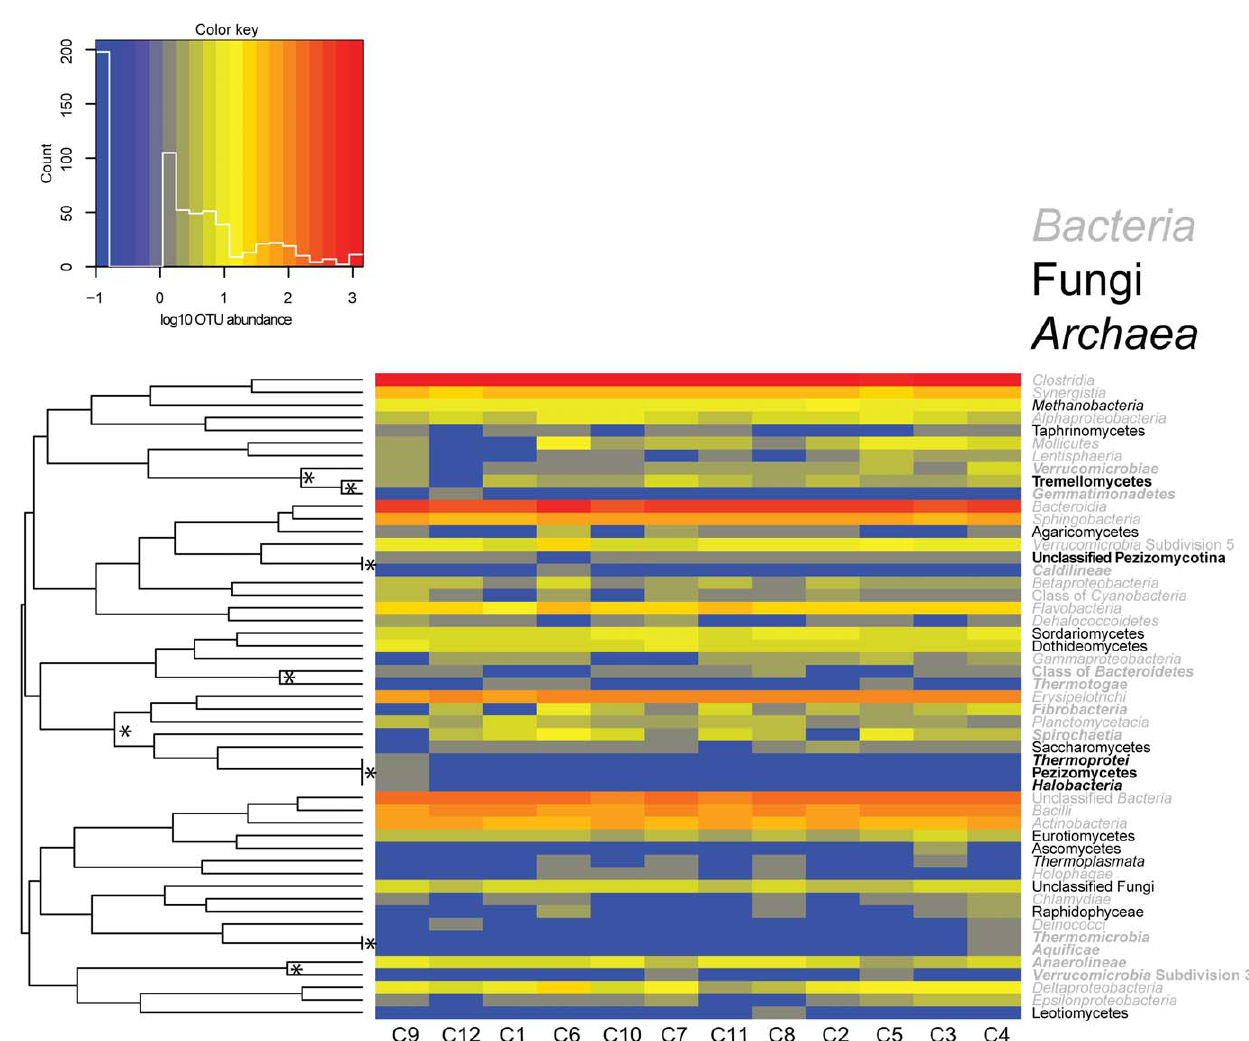
Figure 4. Cross domain OTU comparison based on abundance pattern correlations. Taxonomic classes of Bacteria (gray italics), Fungi (black) and Archaea (black italics) are listed on the right side of the plot. The key denotes log10 transformed abundance patterns. The taxa are clustered based on abundance pattern correlation using a distance metric defined as 1-|r|. The dendrogram on the left side of the plot summarizes the clustering of taxa. Asterisks on nodes denote statistically significant correlations (P , 0.05). The names of significantly significant correlated classes are indicated by bold face font.